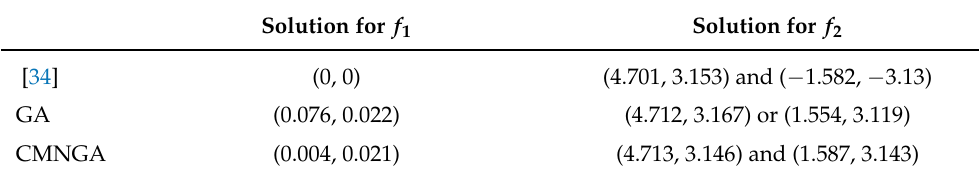
Table 5. Test functions’ solutions